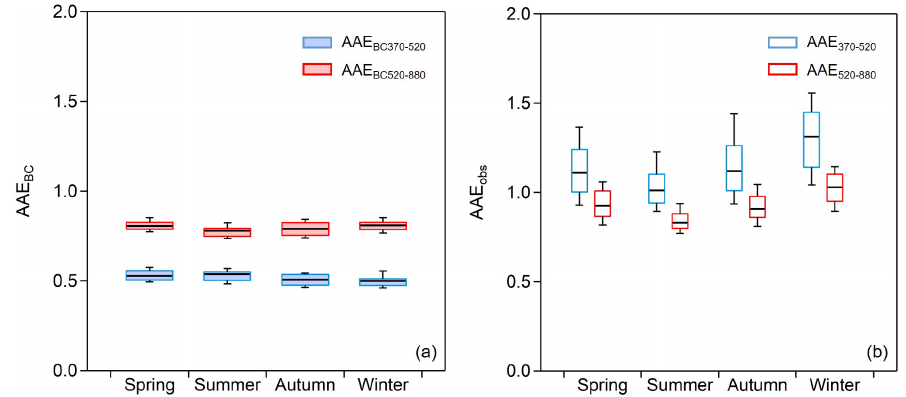
Figure 3. (a) AAE BC370–520 and AAE BC520–880 in different seasons calculated using BC size distribution from SP2 and the core-shell Mie model. (b) AAE 370–520 and AAE 520–880 from observations using the aethalometer.